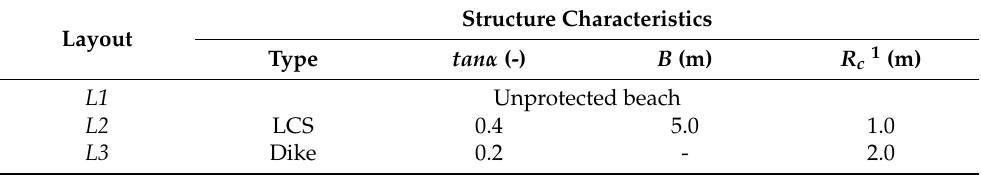
Figure 7. Geographic location and satellite image of the East Macedonia and Thrace Region ([68]; privately processed). Table 3. Layouts used for the applications for coastal structures design evaluation.